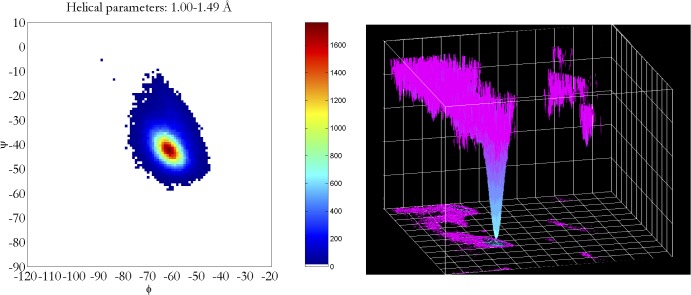
Left: Distribution of helical backbone torsion angles (Φ, Ψ) for 1.0–1.5 Å nominal resolution of 3,462 protein structures from the PDB.Right: Conversion of density of high-resolution helices to a relative energy scale by Boltzmann-weighting the distribution.